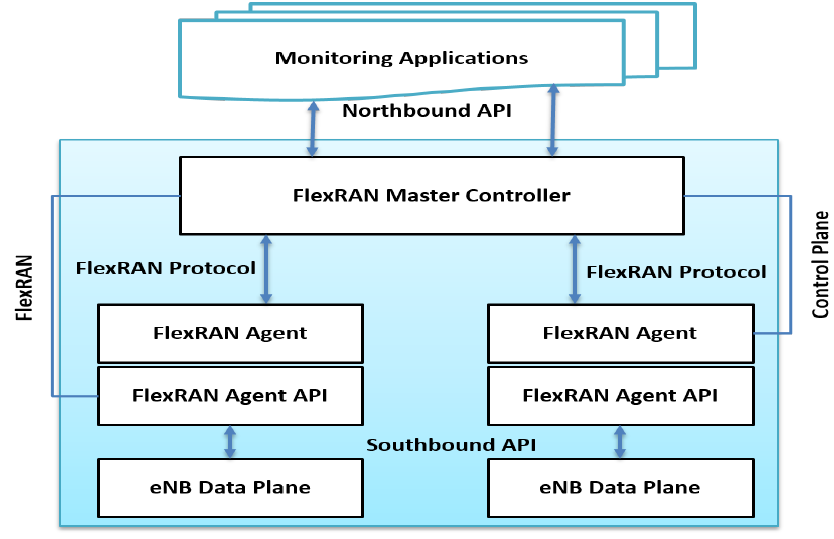
Figure 6. FlexRAN controller abstract